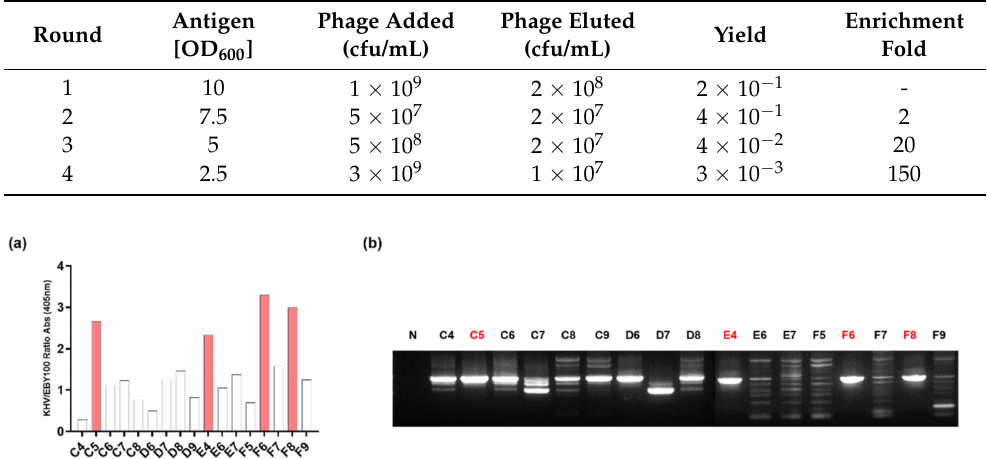
Figure 2. ( a ) The binding affinity of monoclonal phage display scFv was determined after the 4th round of panning. Approximately 17 clones appeared and were selected using an ELISA. The C5, E4, F6, and F8 clones have higher affinity ratios than the other clones. Data are presented as a comparison of absorbance values of KHV antigen to RSIV antigen. ( b ) The scFv fragments of each clone were amplified by PCR using universal primer, pHEN_seq, and LMB3. The amplicons are separated using 1% gel electrophoresis containing ethidium bromide and are compared to the no-template control (lane N). The full-length scFv fragments of C5, E4, F6, and F8 at a size of 1000 bp were collected by gel purification for further